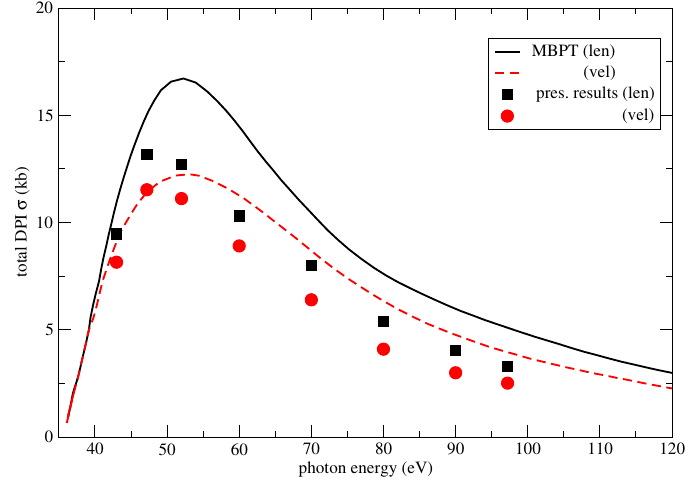
Figure 1. Total double photoionization cross-section of the valence electrons in 3 P carbon. Lines: length (solid black) and velocity (dashed red) gauge results using MBPT from Ref. [22]; present results in length (black squares) and velocity (red circles) gauges are generally slightly smaller in magnitude. 1 kb = 10 − 21 cm 2 .